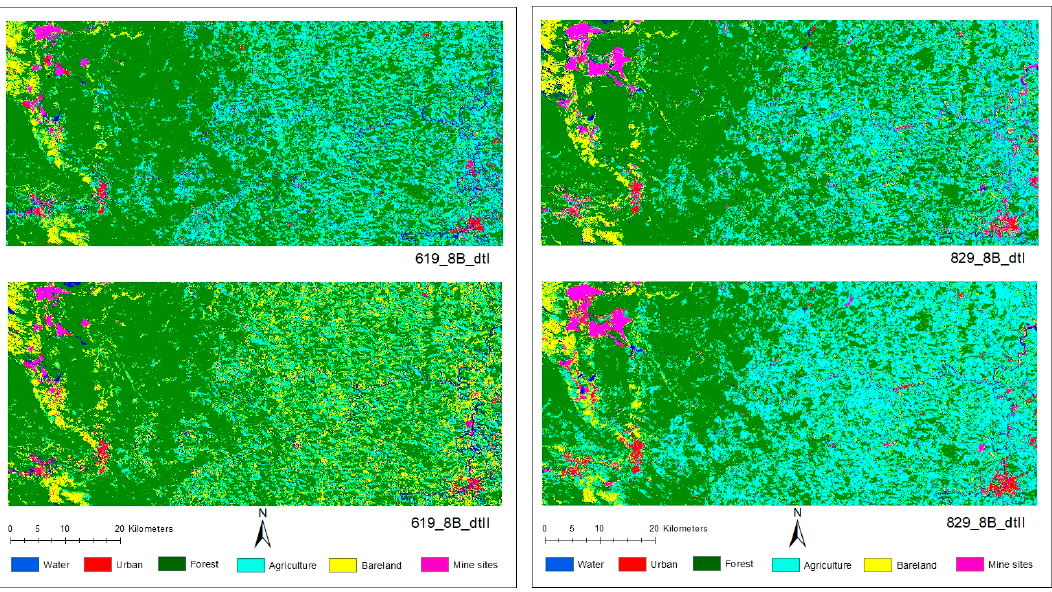
Figure 5. Classification method I and II with 2000 and 2017 images used dataset (B) with DT algorithm.